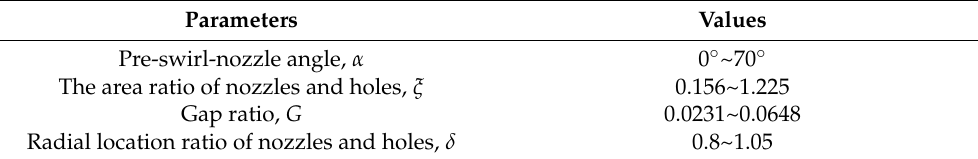
Table 2. The range of